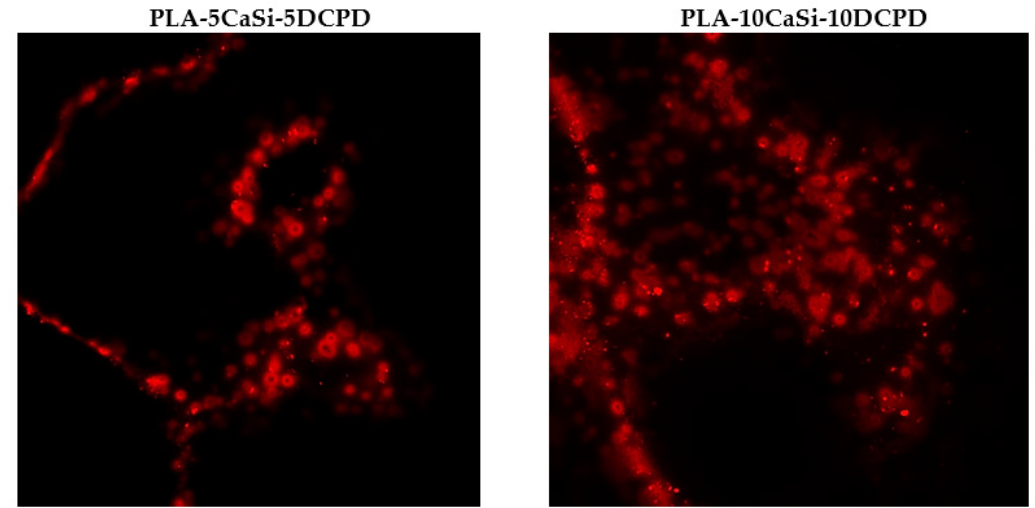
Figure 8. Red labeled exosomes on PLA-5CaSi-5DCPD ( left ) and PLA-10CaSi-10DCPD ( right ) scaffolds .